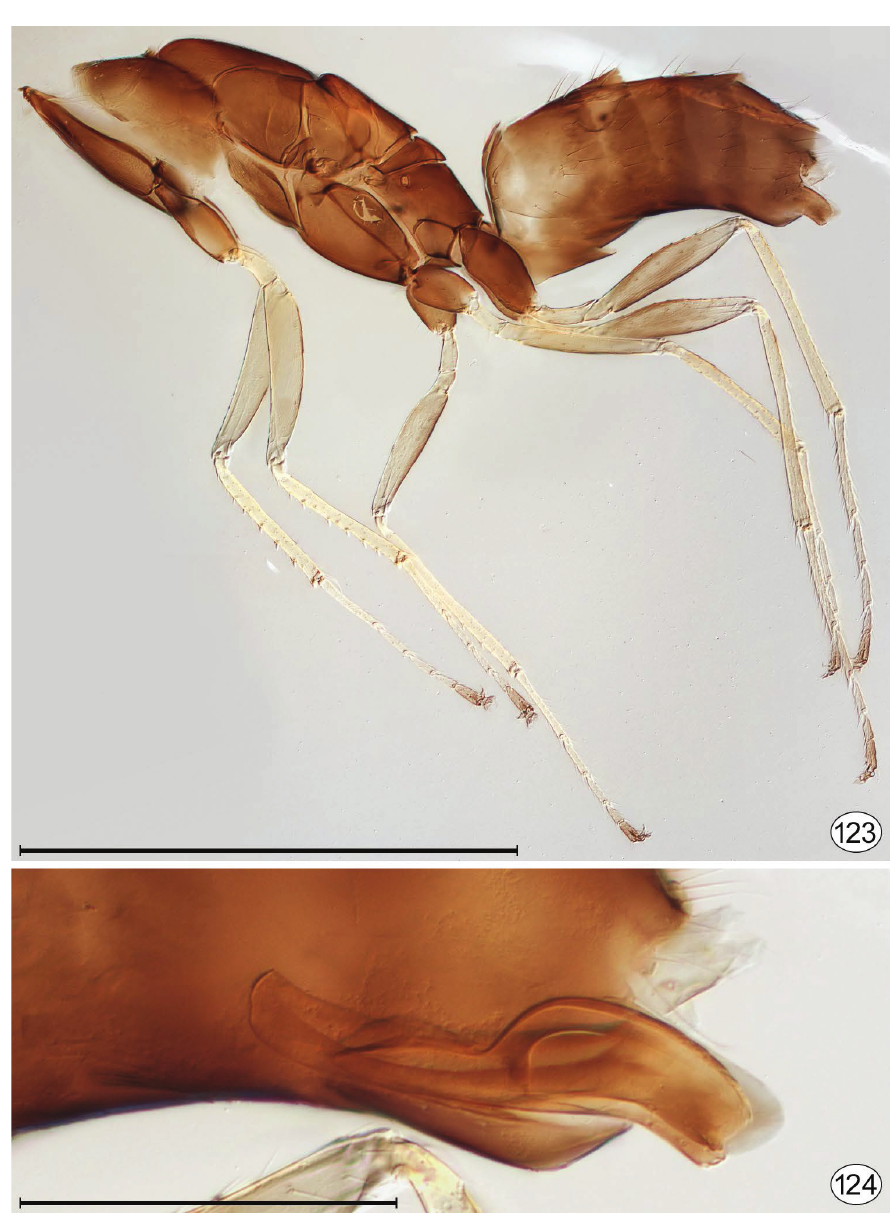
Figures 123, 124. Neotriadomerus longiovipositor , male paratype (14 km W. by N. Hope Vale Mission). 123 mesosoma, legs + metasoma, lateral 124 genitalia, lateral. Scale bar for 123 = 1000 μm; 124 = 200 μm.